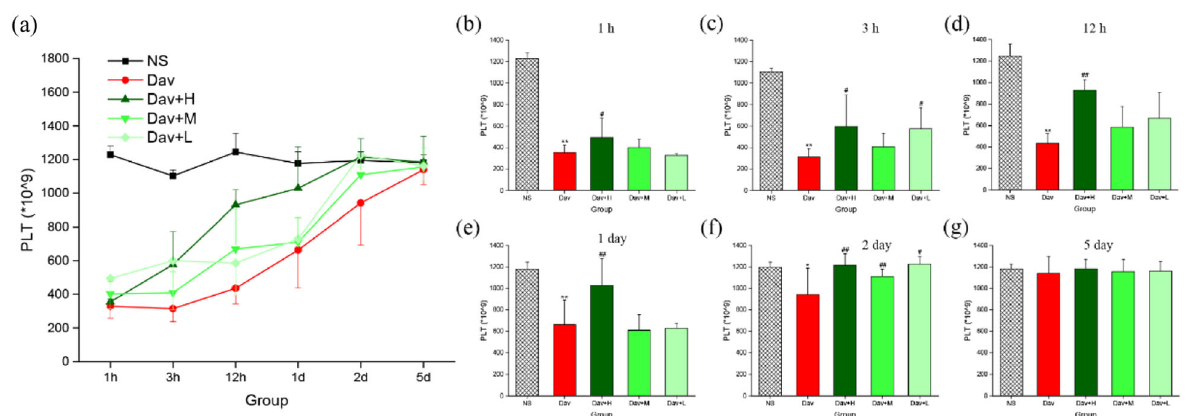
Fig. 11 Effects of Phellodendri Chinensis Cortex Carbonisata-carbon dots (PCCC-CDs) on platelet (PLT) counts in the blood. a PLT changes in 1 h, 3 h, 12 h, 1 day, 2 days, and 5 days. PLT in ( b ) 1 h, ( c ) 3 h, ( d ) 12 h, ( e ) 1 day, ( f ) 2 days, and ( g ) 5 days. Mice were treated with normal saline (NS), D.acutus venom (Dav, 1 mg/kg) and high (H), medium (M), and low (L) doses of PCCC-CDs + Dav (1 mg/kg). Data are represented as mean ± SD of six animals of each group. * p < 0.05 and ** p < 0.01 compared with control group treated with normal saline (NS). # p < 0.05 compared with Dav